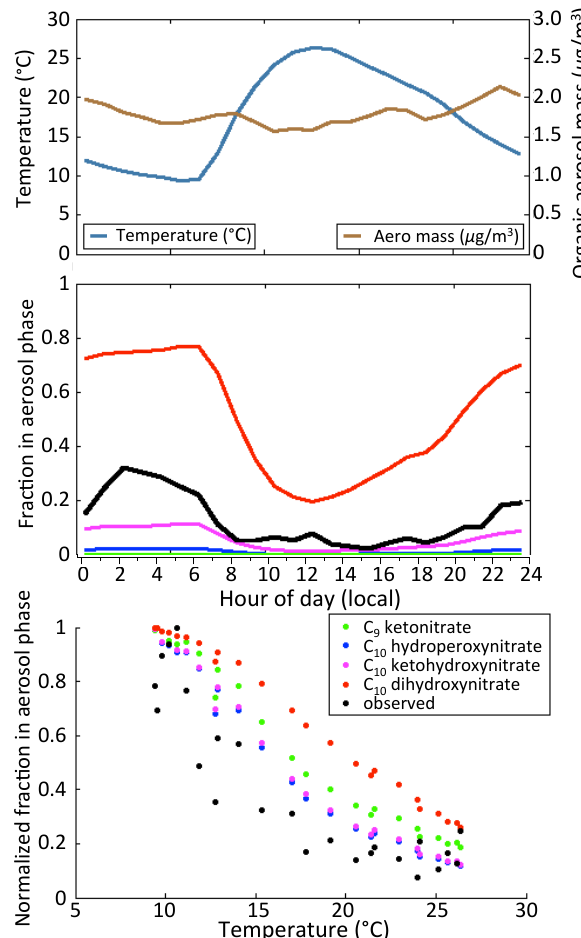
Fig. 9. Observed (black, same as in Fig. 5) and modeled fraction of organic nitrate in the aerosol phase over the diurnal cycle in temperature (blue) and background organic aerosol mass (measured by AMS, brown), based on calculated vapor pressures for a series of possible nitrate structures (indicated in legend). None of these structures can capture the observed dynamic range in aerosol frac- tion. Bottom panel shows aerosol fraction for the same series of molecules, demonstrating that the observed aerosol fraction does not fully scale with temperature as simple repartitioning of the same nitrates would predict. Data are normalized to peak fraction to fa- cilitate comparison of the